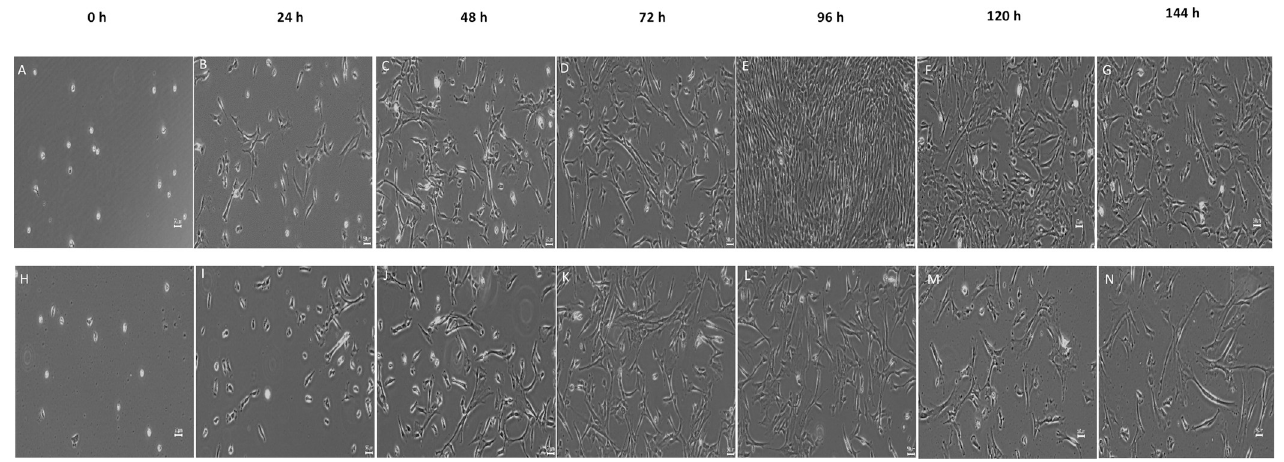
Fig 4. Morphology of untreated (A-G) and MOL treated (H-N) hWJ-MSCs from 0 h to 144 h (Magnification, x4; scale bar = 50 μ m).